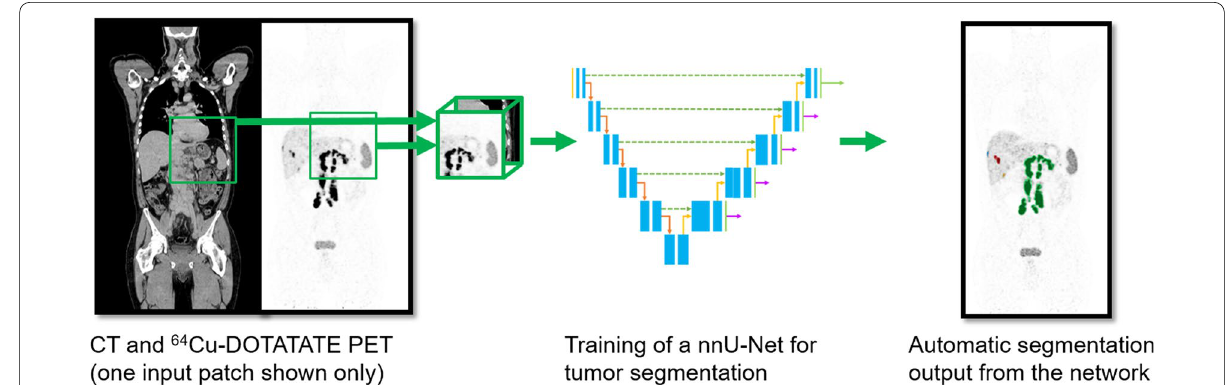
Fig. 1 Total tumor segmentation of neuroendocrine neoplasms by a convolutional neural